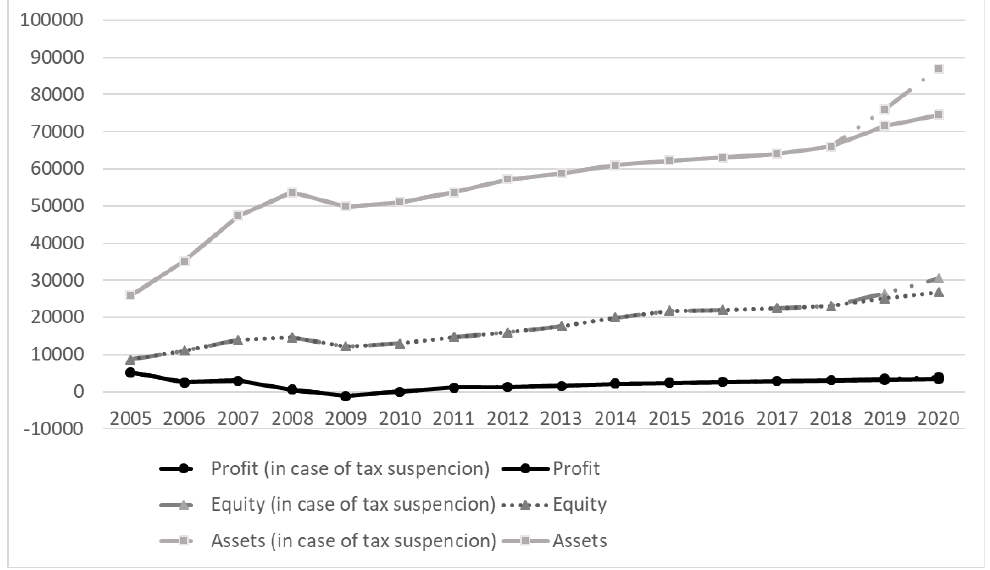
Fig. 3. Assessment of profit, equity, and assets of businesses in Latvia, million EUR (made by the authors using data from Amadeus,